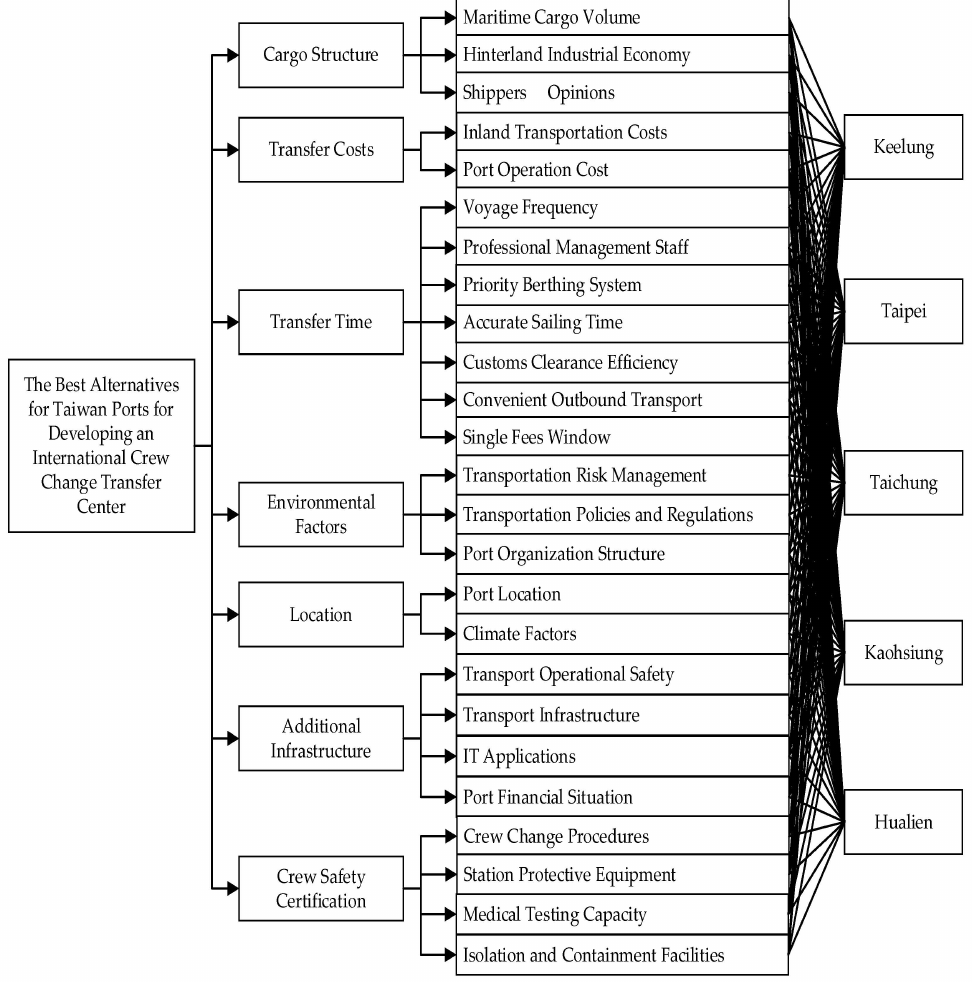
Figure 1. Key influencing factors and best alternatives for developing international crew transit centers in Taiwanese